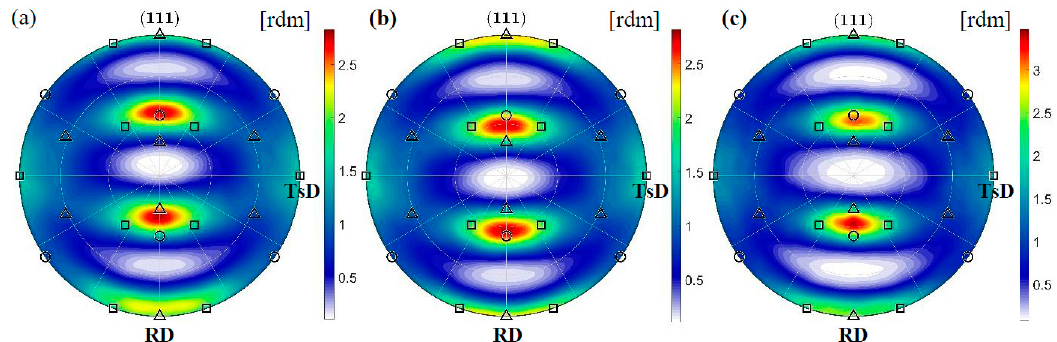
Figure 6. {1 1 1} pole figures for austenite in the area located 4 mm from the fracture surface of specimens stretched at the temperature of 4.2 K ( a ), 77 K ( b ) and RT ( c ). The Brass, Goss and Cu texture components are denoted by squares, circles and tringles, respectively. TsD || TD denotes the tensile direction.